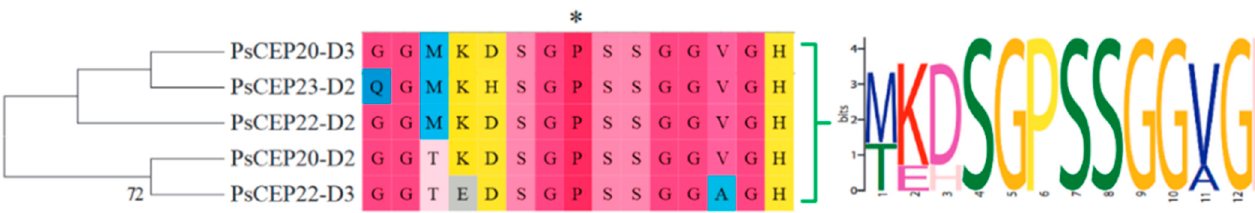
Figure 5. Alignment of the PIP peptide sequences found in the PsCEP20, PsCEP22 and PsCEP23 precursor proteins. WebLogo representation of the conserved domain is shown. The Pro8 residue is marked with asterisk.